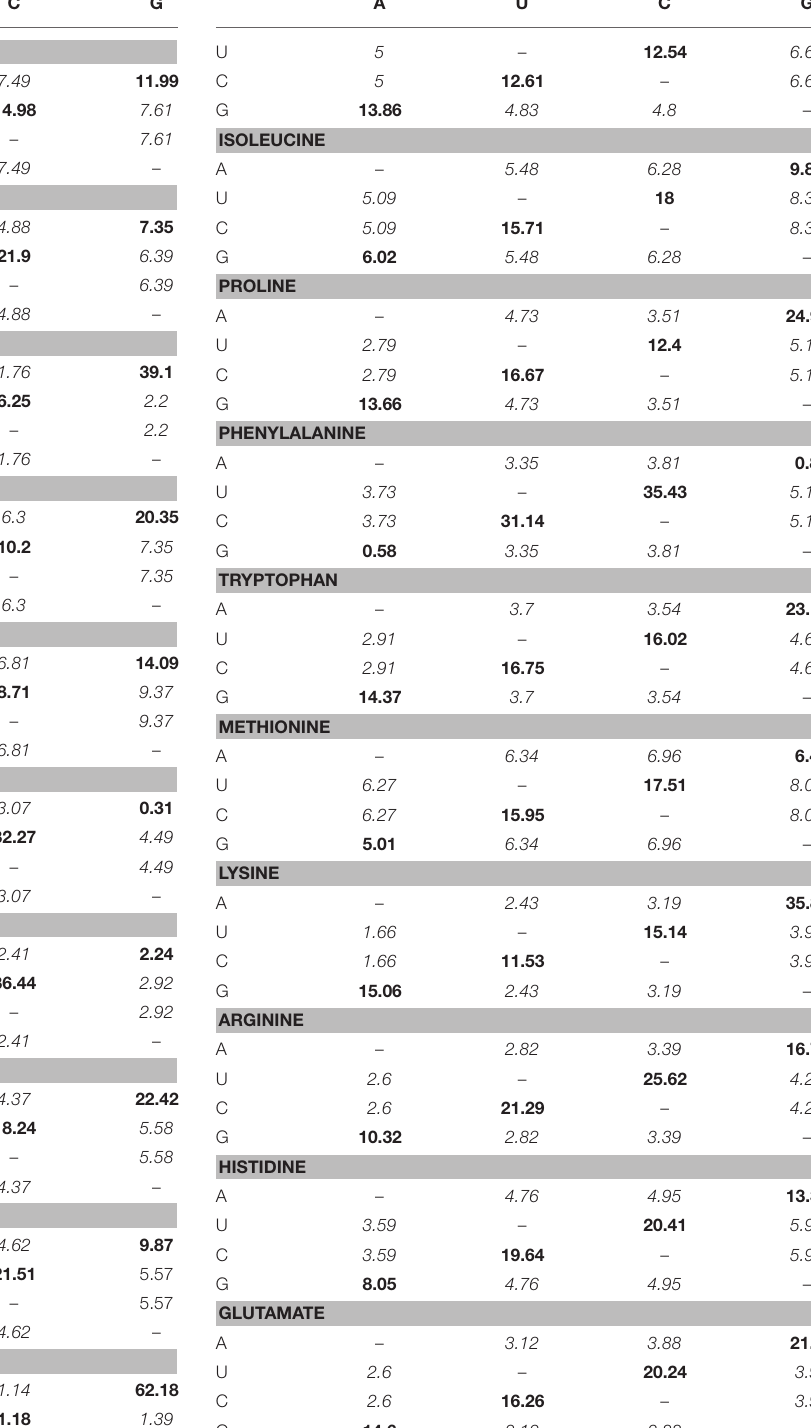
TABLE 6 | Nucleotide substitution matrix of O. sativa tRNAs. A U C